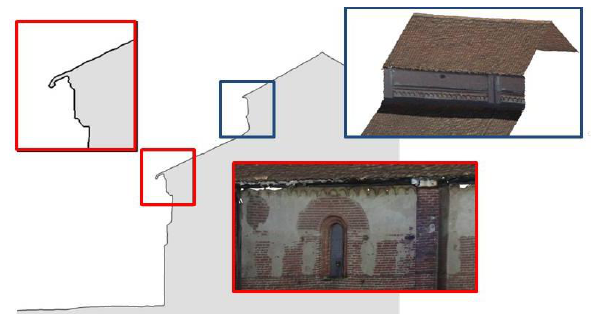
Figure. 23. High details of ledges and adjacent areas on final textured model